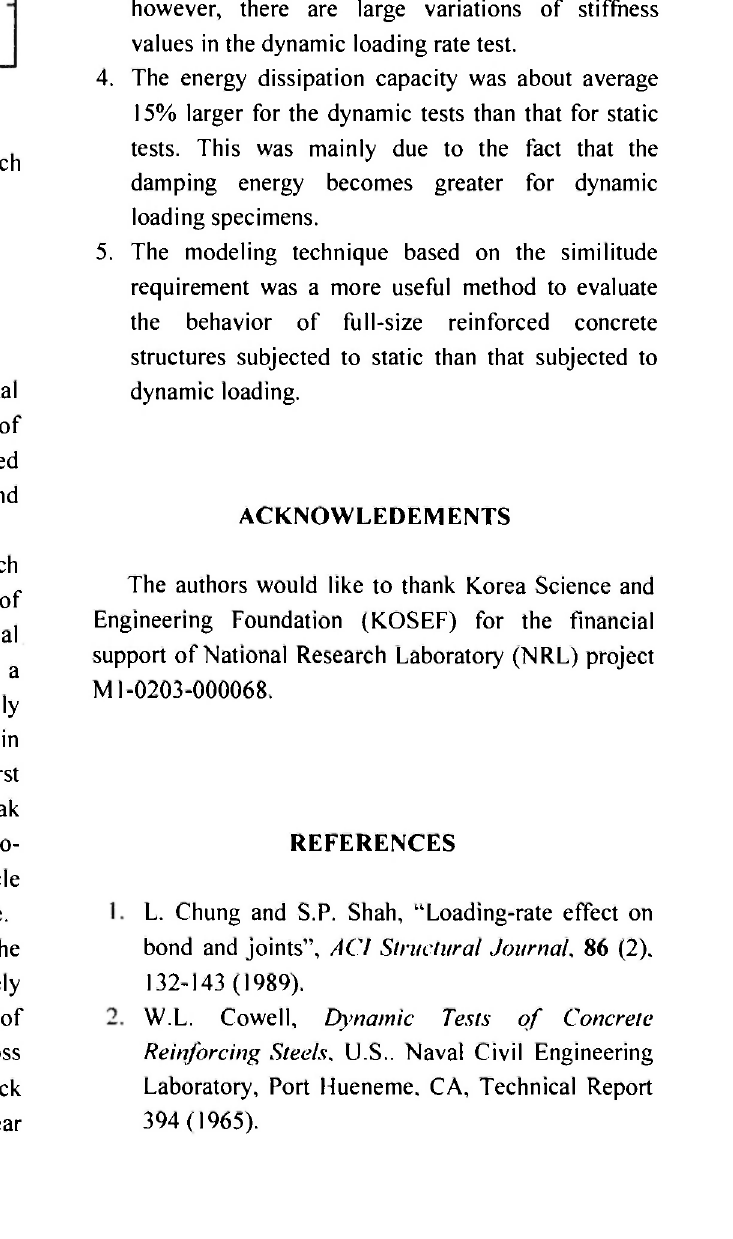
Fig. 23: Energy dissipation comparison for each